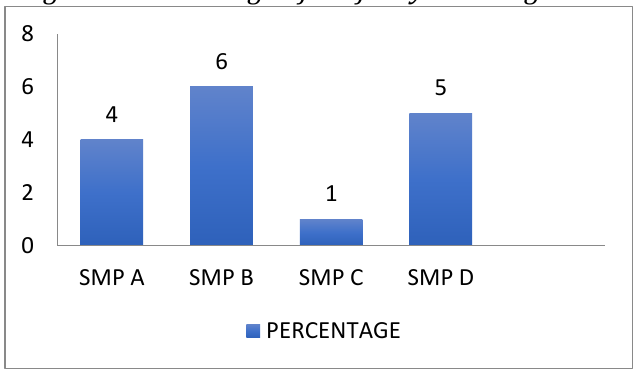
Figure 2. Percentage of Perfectly Working